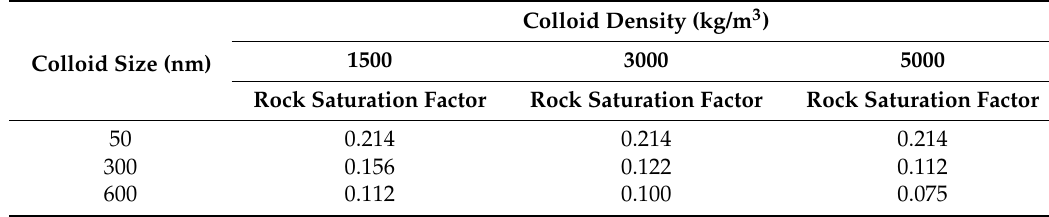
Table 3. Measured Rock Saturation Factor values for different colloid density and